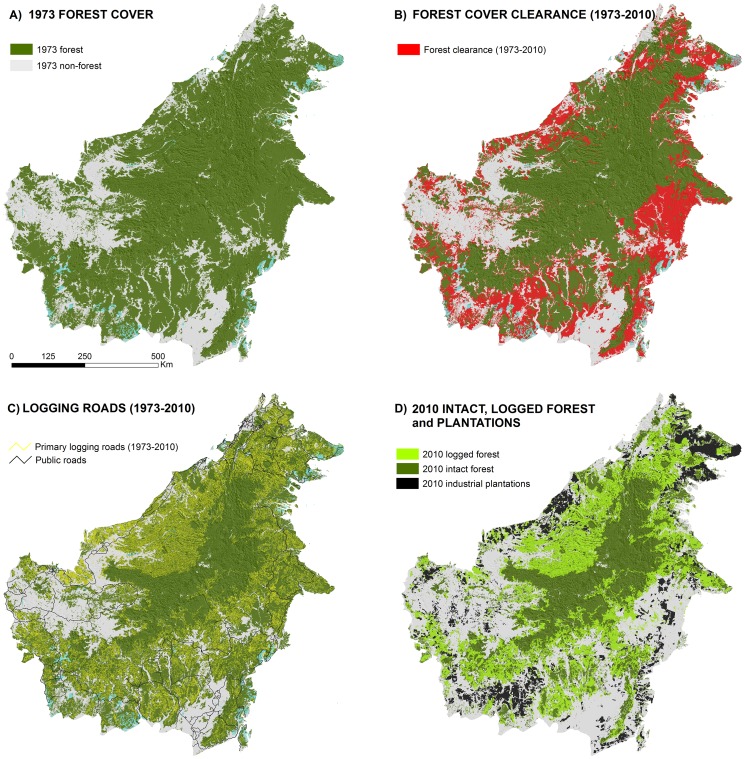
Four decades of forest persistence, clearance and logging on Borneo.Forest (dark green) and non-forest (white) in year 1973, and residual clouds (cyan) in Panel A. Areas of forest loss during 1973–2010 (red) in Panel B. Primary logging roads from 1973–2010 (yellow lines) in Panel C. Remaining intact forest (dark green), remaining logged forest (light green), and industrial oil palm and timber plantations (Black) in year 2010 in Panel D.